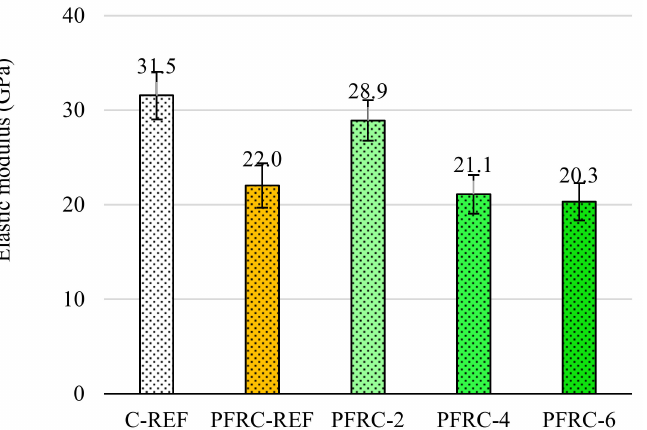
Figure 3. Elastic modulus (E cm ) values for all mixtures at 28 days, along with the standard devia- tion